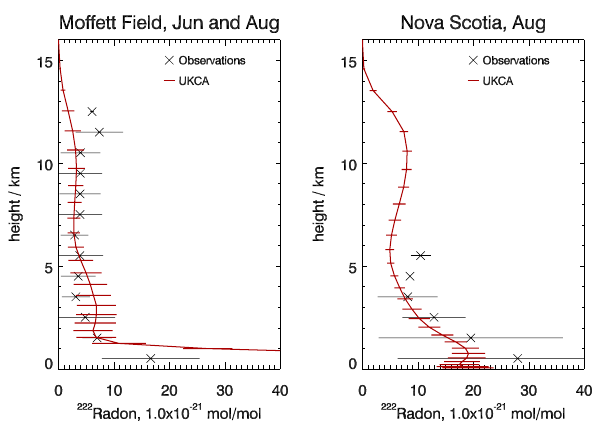
Fig. 4. Comparison of modelled profiles of radon in units of 10 − 21 mol mol − 1 with observations at two different sites. Obser- vations are shown as black crosses and the UKCA model is shown in red. Measurements from Moffett Field and Nova Scotia are taken from Kritz et al. (1998) and Zaucker et al. (1996),